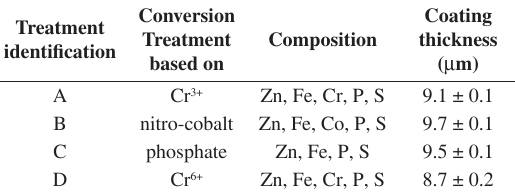
Table 1. Thickness and composition of zinc coatings after conversion